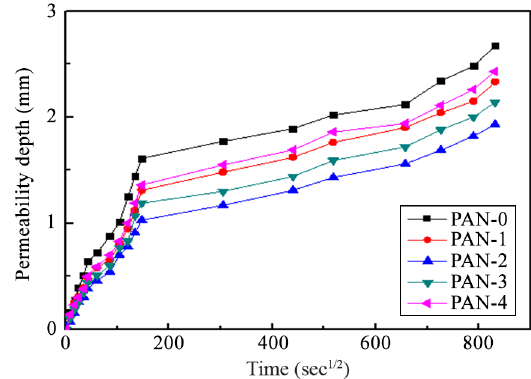
Figure 3. Permeability resistance performance of PAN fiber reinforced concrete.